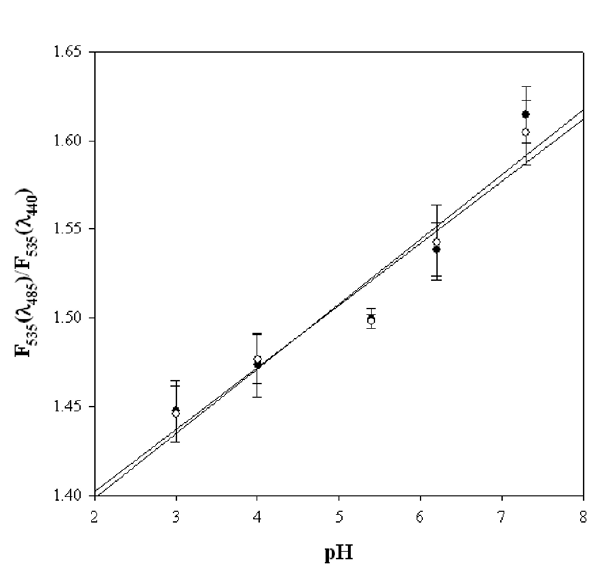
Figure 5 Effect of HRP-catalyzed oxidation on the pH-depend- ency of fluorescein-dextran fluorescence. Fluorescein- dextran (final concentration at 30 µ g/ml) was prepared in MES calibration buffers with pHs ranging from 3.0 to 7.3. These solutions were then incubated at 37 ° C for 30 min, in the absence ( (cid:1) ) or presence ( (cid:2) ) of H 2 O 2 and HRP (final concentrations are 1 µ M and 4 µ g/mL, respectively). The flu- orescence emission ratio of F 535 ( λ 485 )/F 535 ( λ 440 ) was then